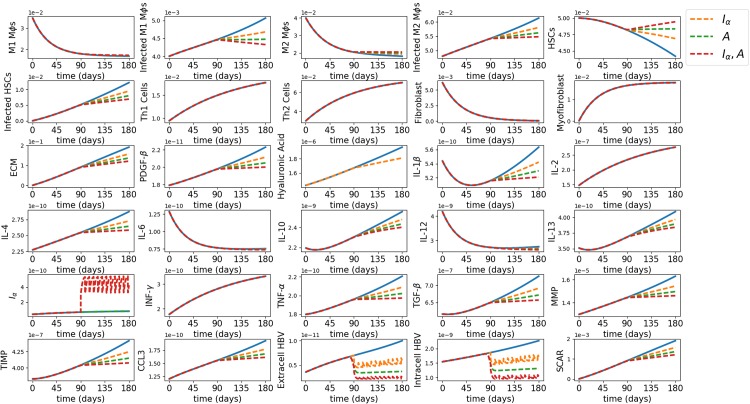
Monotherapy and combination therapy with intermittent IFN-α and continuous adefovir.The horizontal axes scale the time in days and the vertical axes scale the average densities in g/cm3 for all the variables for the first 180 days since the start of the disease, in control case (blue) and with treatment (IFN-α–orange, adefovir–blue and combination–red).